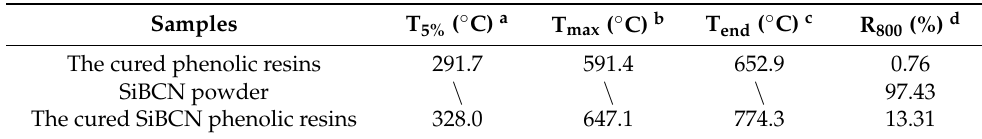
Table 2. TGA results under air atmosphere of the cured phenolic resins and the cured SiBCN modified phenolic resins.